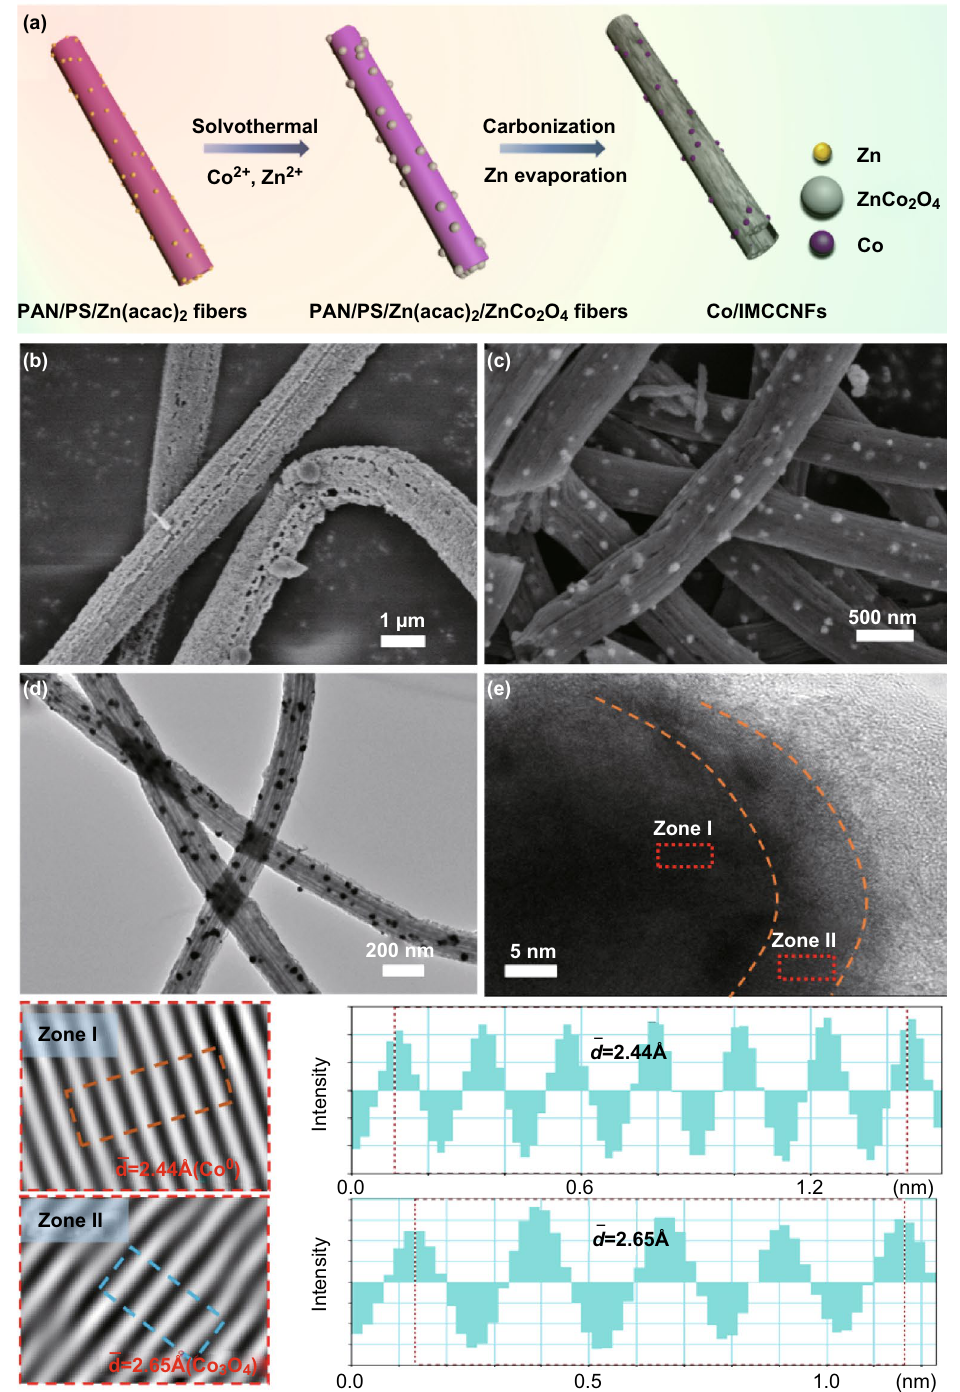
Fig. 2 a Schematic of the synthesis of the Co/IMCCNFs. b, c SEM images of the ZnCo 2 O 4 NFs and Co/IMCCNFs. d, e TEM and HRTEM images of the Co/IMCCNFs (the bottom images show the lattice fringes and lattice spacing of the